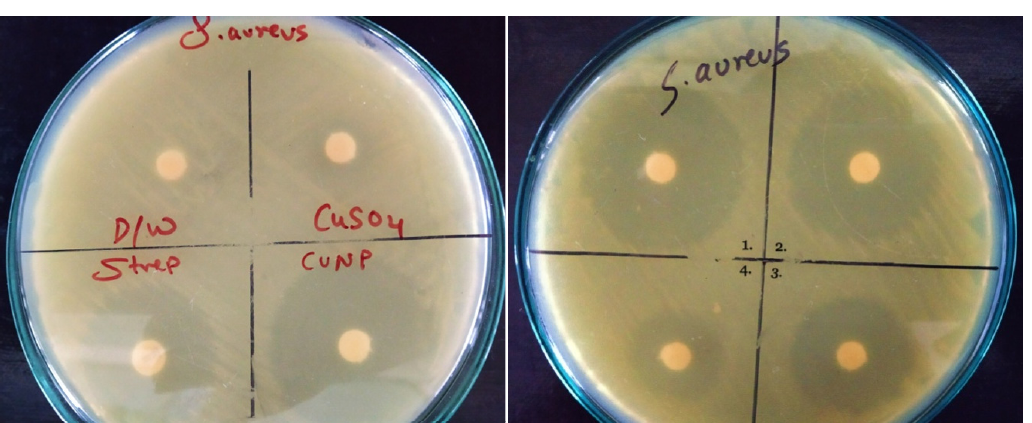
Fig. 9A. & Fig. 9B. Antimicrobial sensitivity of Staphylococcus